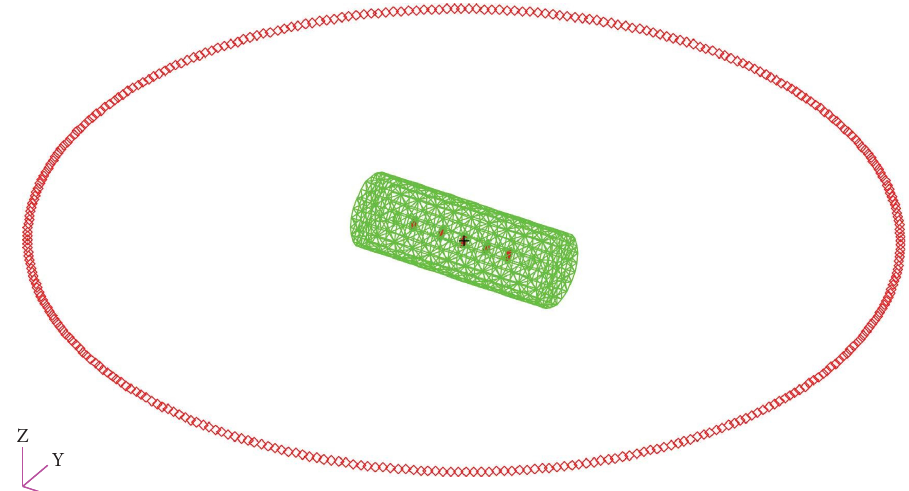
Figure 12: Artifcial boundary elements and acoustic feld points in the FE-FE-BE method.